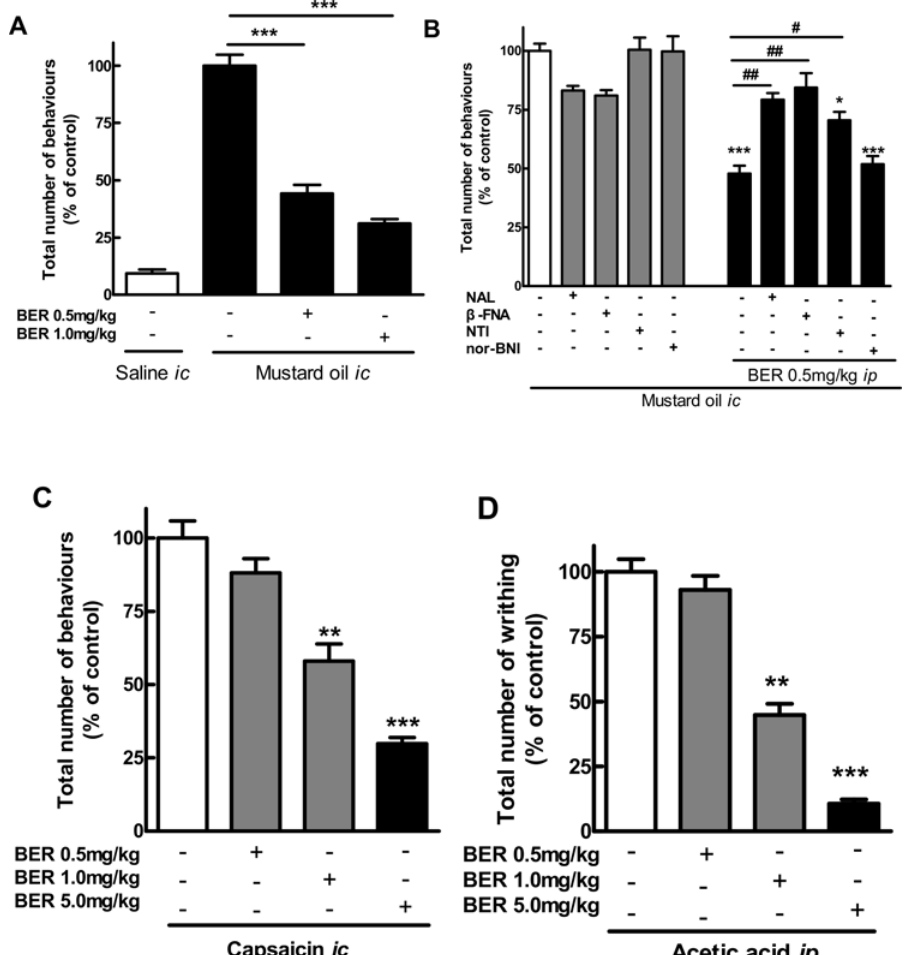
Fig 3. Antinociceptive effect of berberine (BER) in mouse models of pain. Data are mean ± SE ( n = 6 – 10).A: I . p . berberine (0.5 and 1 mg/kg)reduced the number of pain-related behaviors in the mustard oil ( i . c .)-induced model of visceral pain. *** P < 0.001, vs . control. B: I . p . opioid antagonists naloxone (NAL, 1 mg/kg), β -funaltrexamine ( β -FNA,1 mg/kg) and naltrindole (NTI, 1 mg/kg), but not nor-binaltorphimine (nor- BNI,10 mg/kg)blocked the effects of berberine(BER, 0.5 mg/kg, i . p .)on the number of pain-related behaviors in the mustard oil model. * P < 0.05; *** P < 0.001, vs . control; # P < 0.05; ## P < 0.01, berberine + antagonists vs . berberine alone. C: I . p . berberine (0.5, 1 and 5 mg/kg)reduced the number of pain-related behaviors in the capsaicin-induced model of visceral pain. ** P < 0.01; *** P < 0.001, vs . control. D: I . p . berberine (0.5, 1